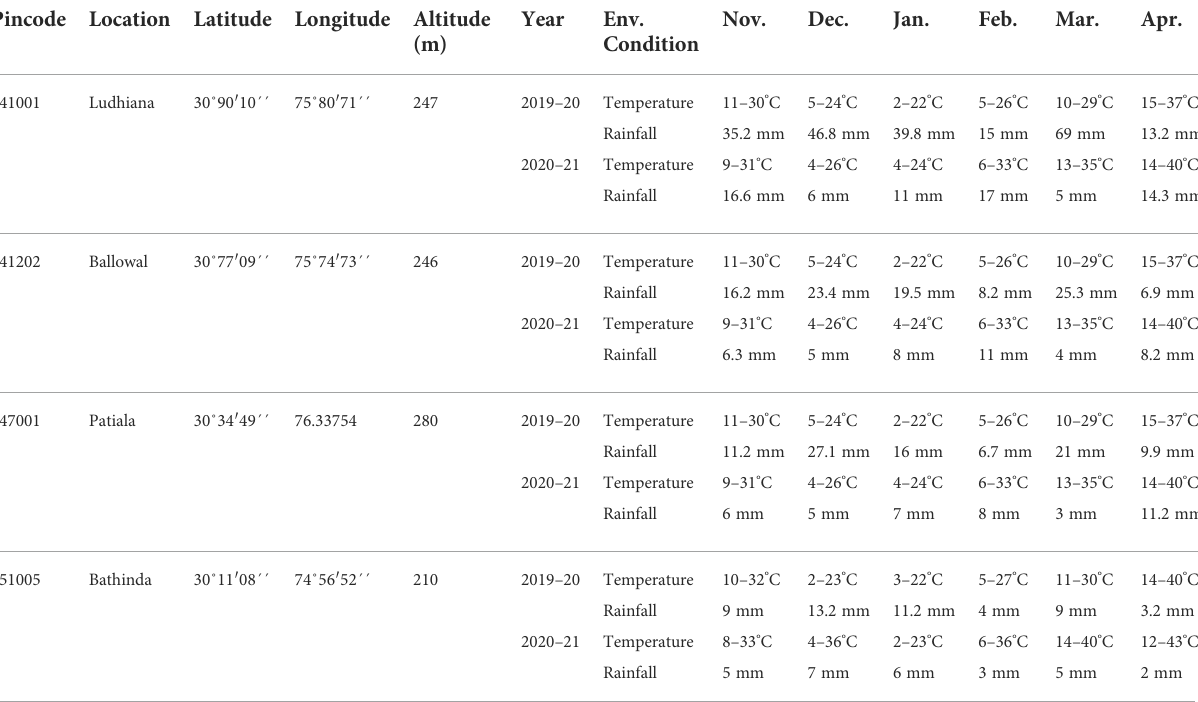
TABLE 2 Details of environmental condition for the experimental locations (Ludhiana, Ballowal, Patiala, and Bathinda) during two consecutive years (2019 – 20, and 2020 – 21). Pincode Location Latitude Longitude Altitude (m)